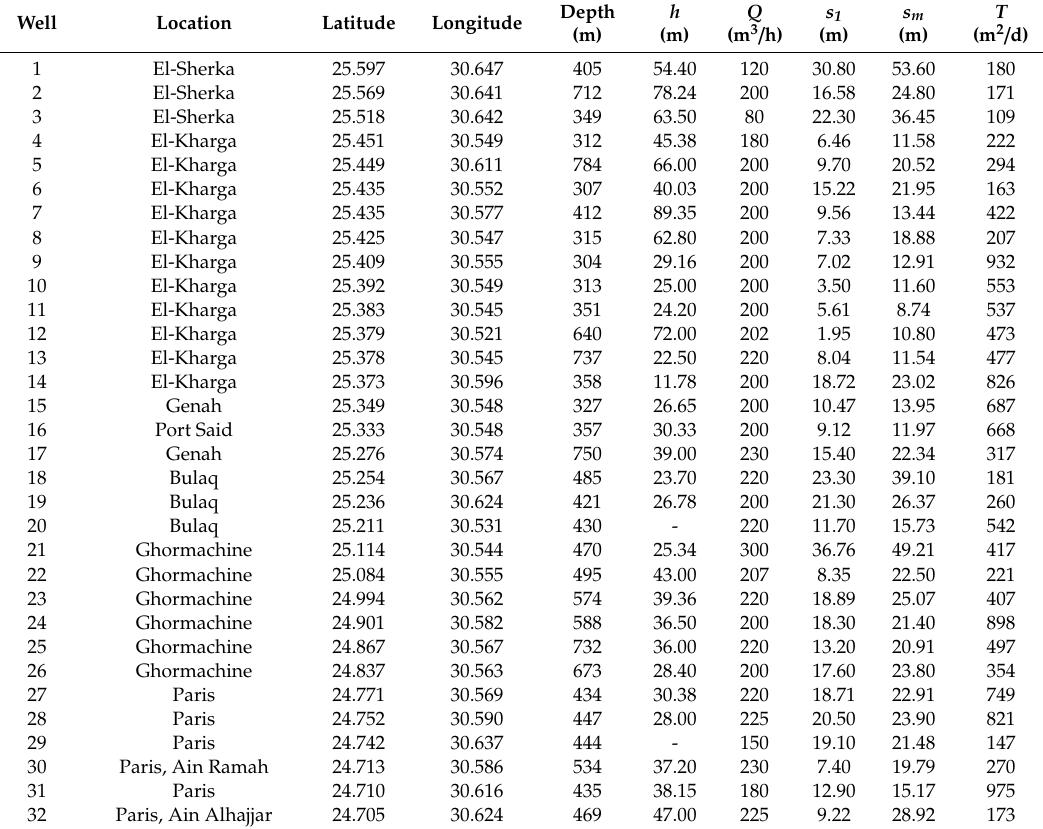
Table 1. List of the pumping test wells with location, coordinates, well depth, depth to the static water level ( h ), pumping test rate ( Q ), drawdown after 1 min ( s 1 ), maximum drawdown ( s m ) at the end of the pumping test and estimated transmissivity ( T